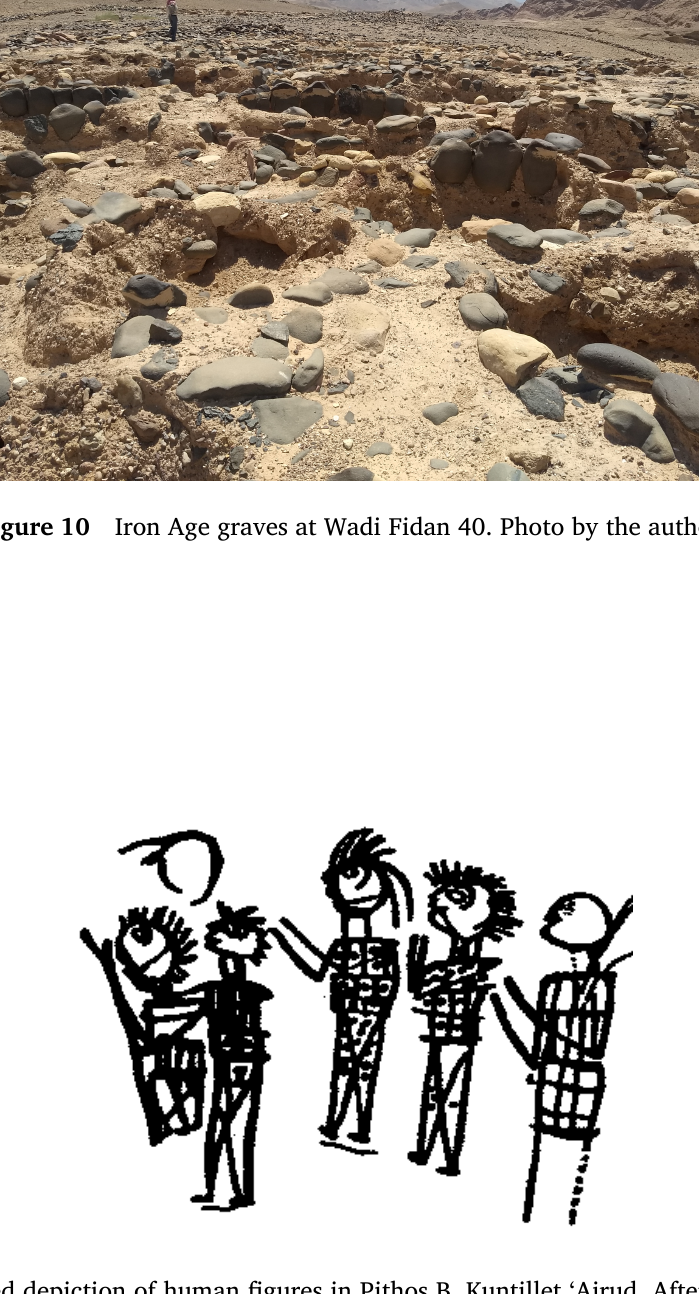
Figure 11 Painted depiction of human figures in Pithos B, Kuntillet ‘Ajrud. After Beck 1982, figure 16. With kind permission from the Institute of Archaeology, Tel Aviv